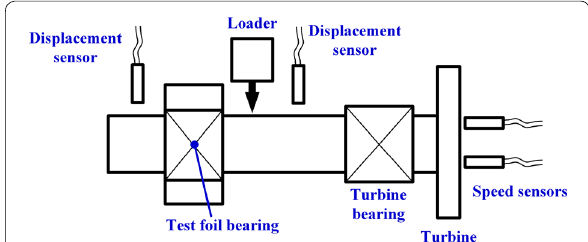
Figure 11 Experimental scheme of NASA foil bearing turbopump demonstrations